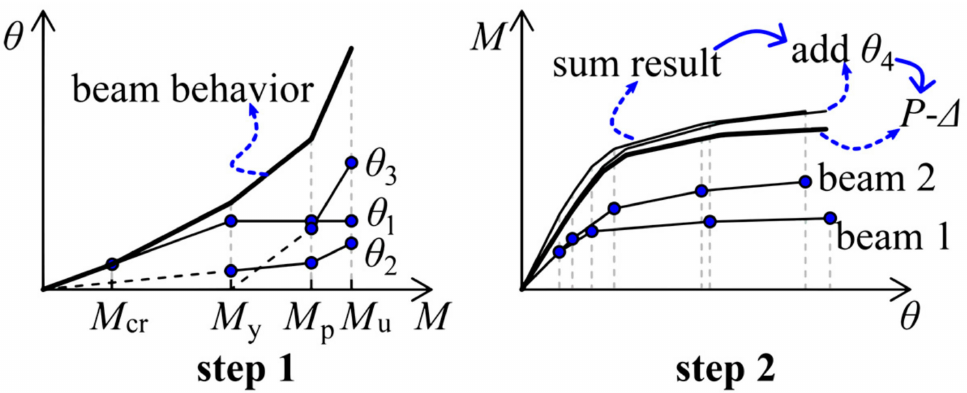
Figure 7. Calculation method of moment–rotation relationship for cruciform